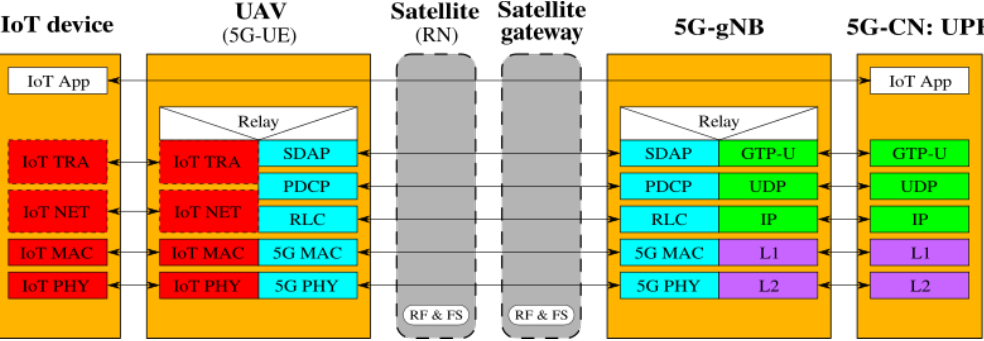
Figure 2. 5G-UE on the UAV, satellite as RN, and terrestrial 5G-gNB.